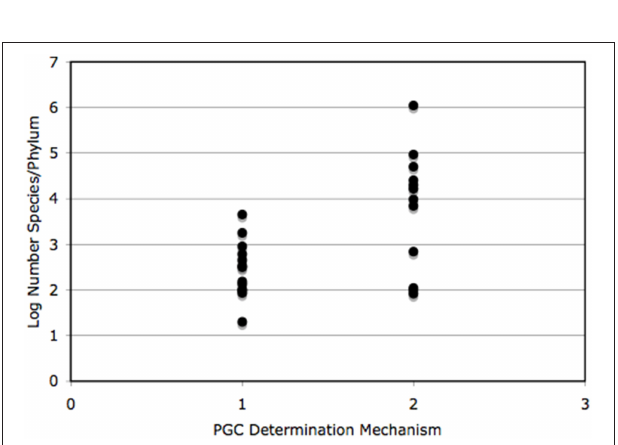
FIGURE 1 | Log number of species for phyla whose germ cell determination mechanism is known. I, Induced mechanism; D, determinative mechanism. This graph mimics Figure 1 in Buss (1988).